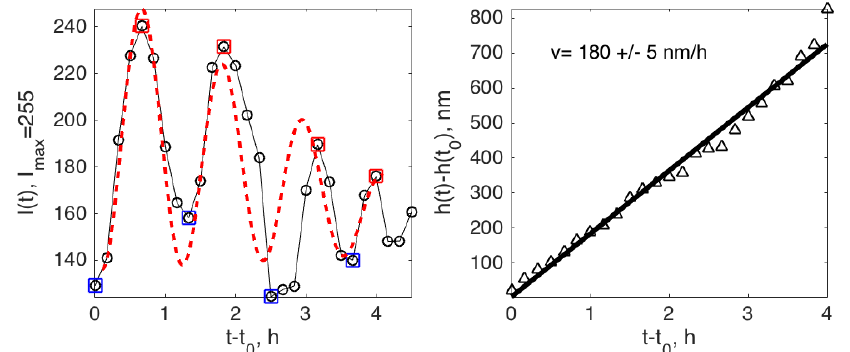
Figure 4. ( Left ) Intensity in the middle of Crystal B’s (see Figure 3) surface with time. Circles denote data from images; blue and red squares are data points used to rescale the amplitude before applying arcsine. The red dashed line shows the fit to data. ( Right ) Triangles’ height is calculated from intensity data as a function of time, and the black line is the least squares